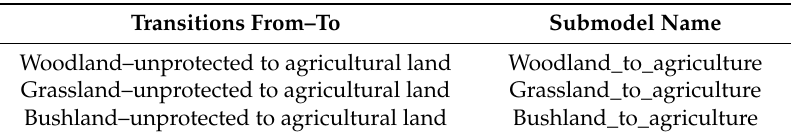
Table 2. Transitions and submodels